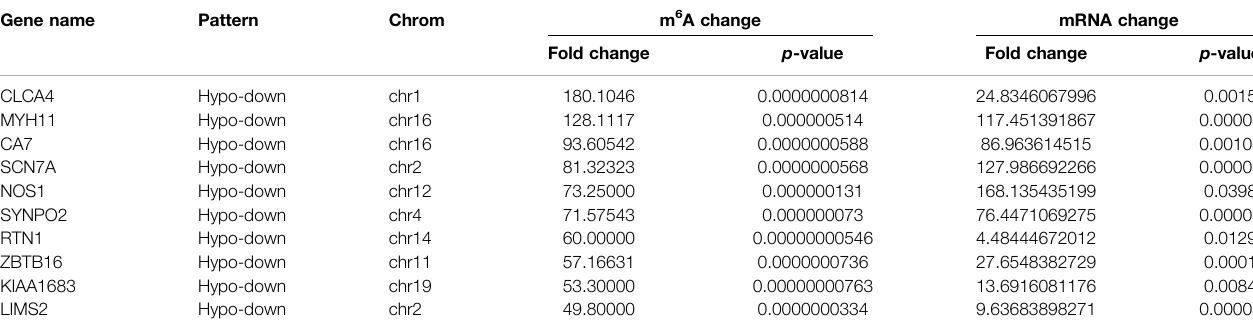
TABLE 4 | The top 10 hypomethylated and downregulated